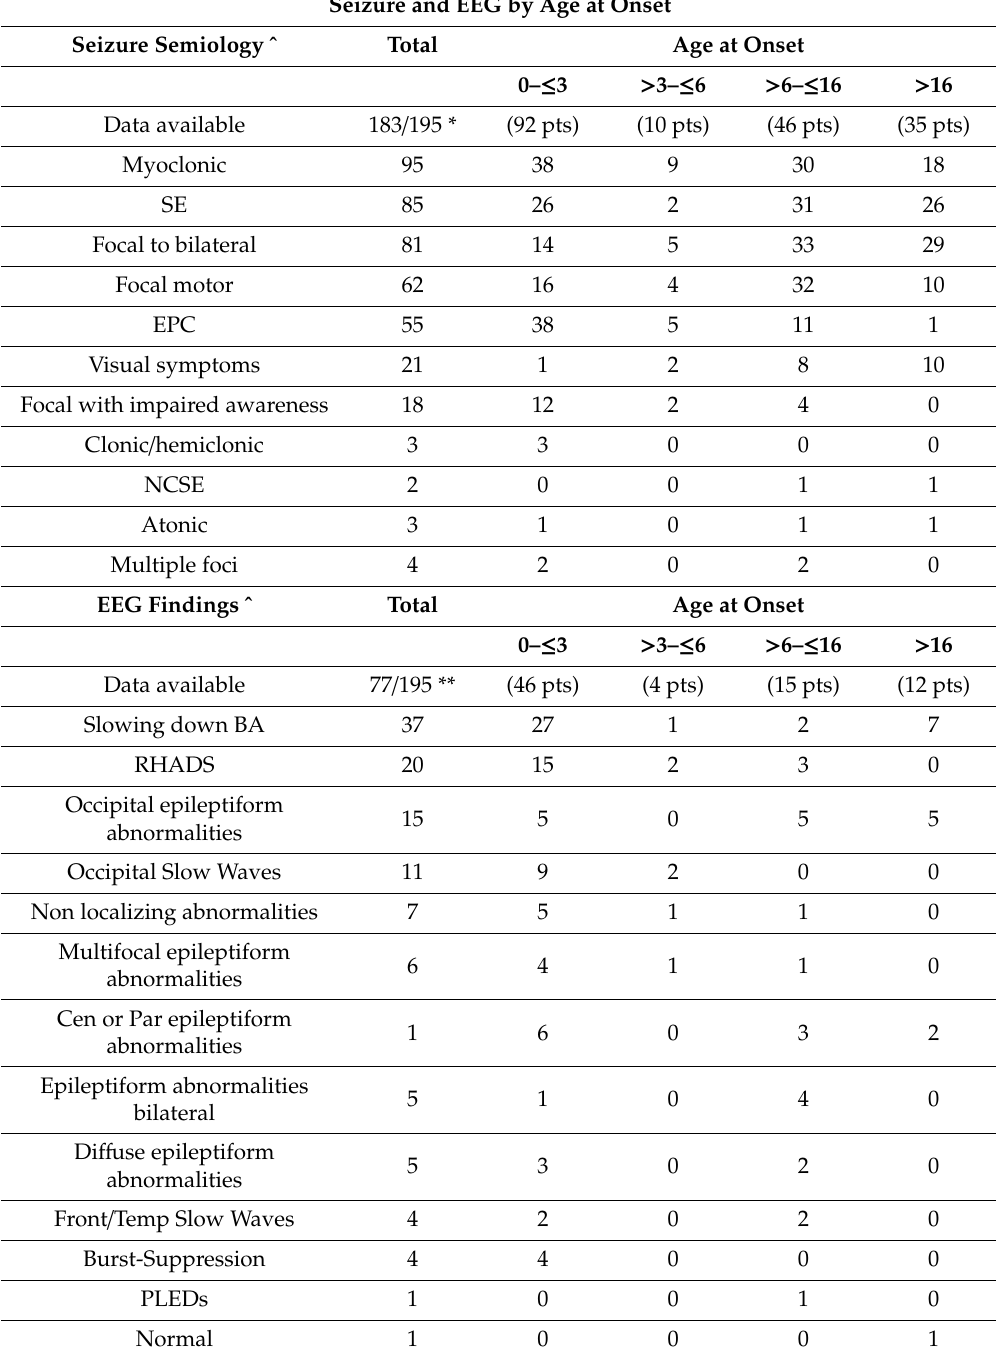
Table 2. Seizure and EEG by age at onset. Seizure and EEG by Age at